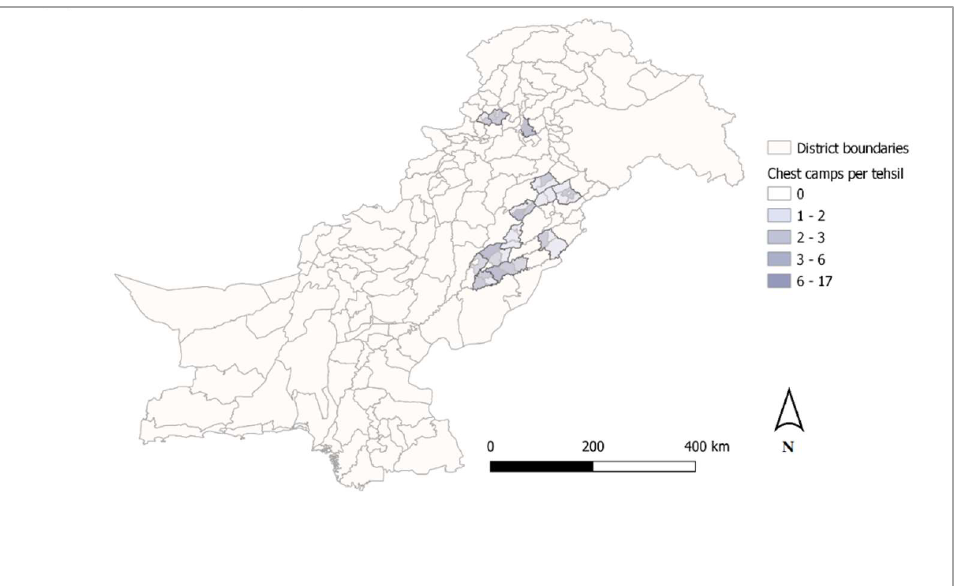
Figure 1. Intervention Area for Hybrid CAPI/PAPI Data Collection in Chest Camps,